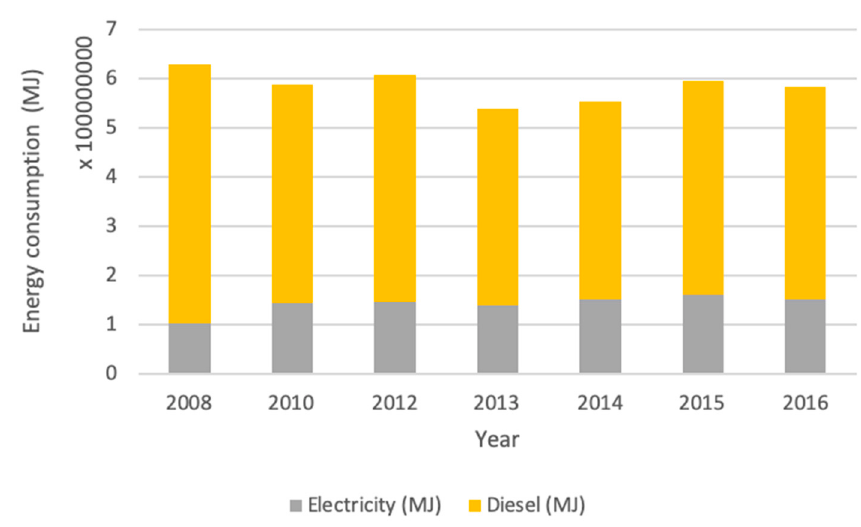
Figure 3. Energy consumption by energy type from 2008 to 2016.